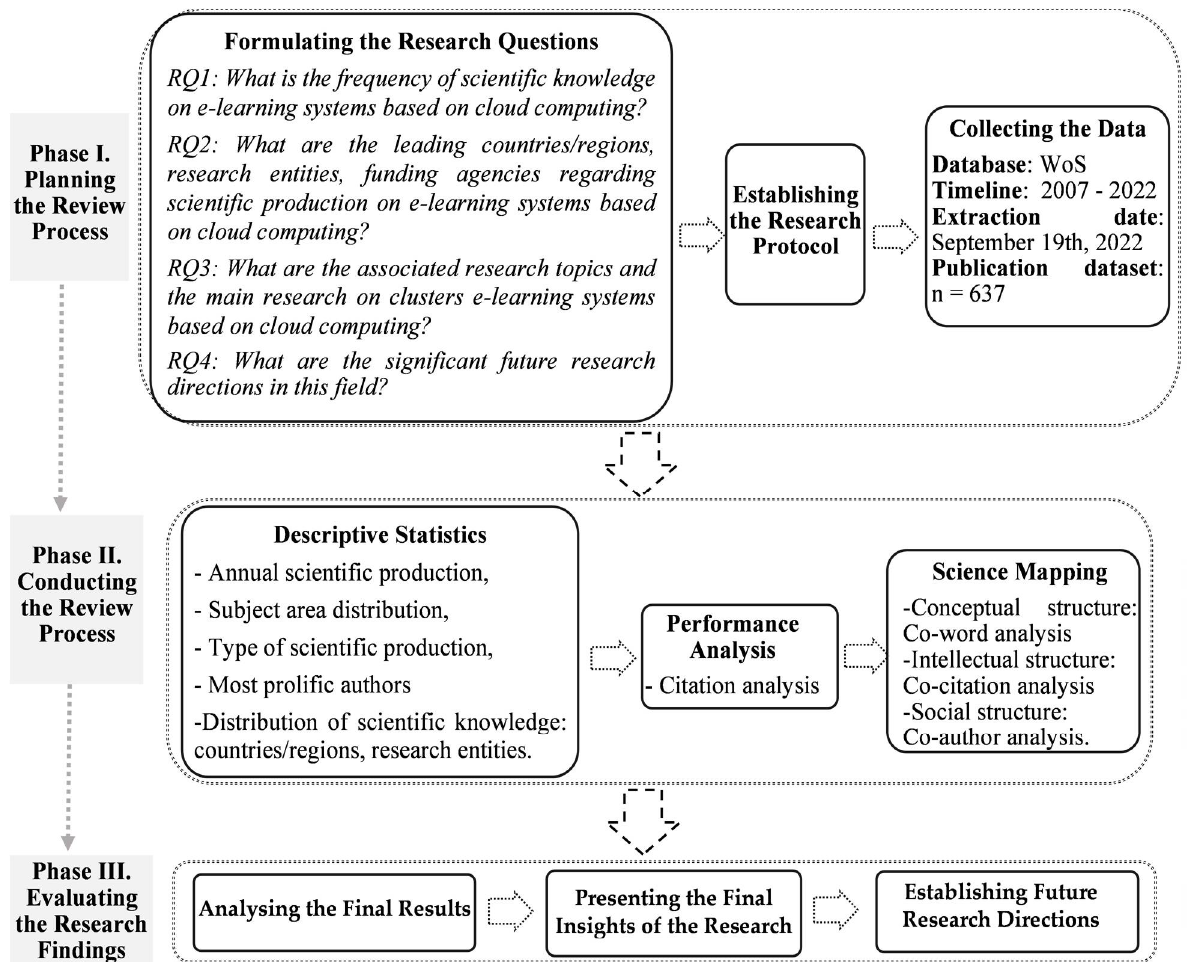
Figure 3. Research Protocol adapted from [60,72].